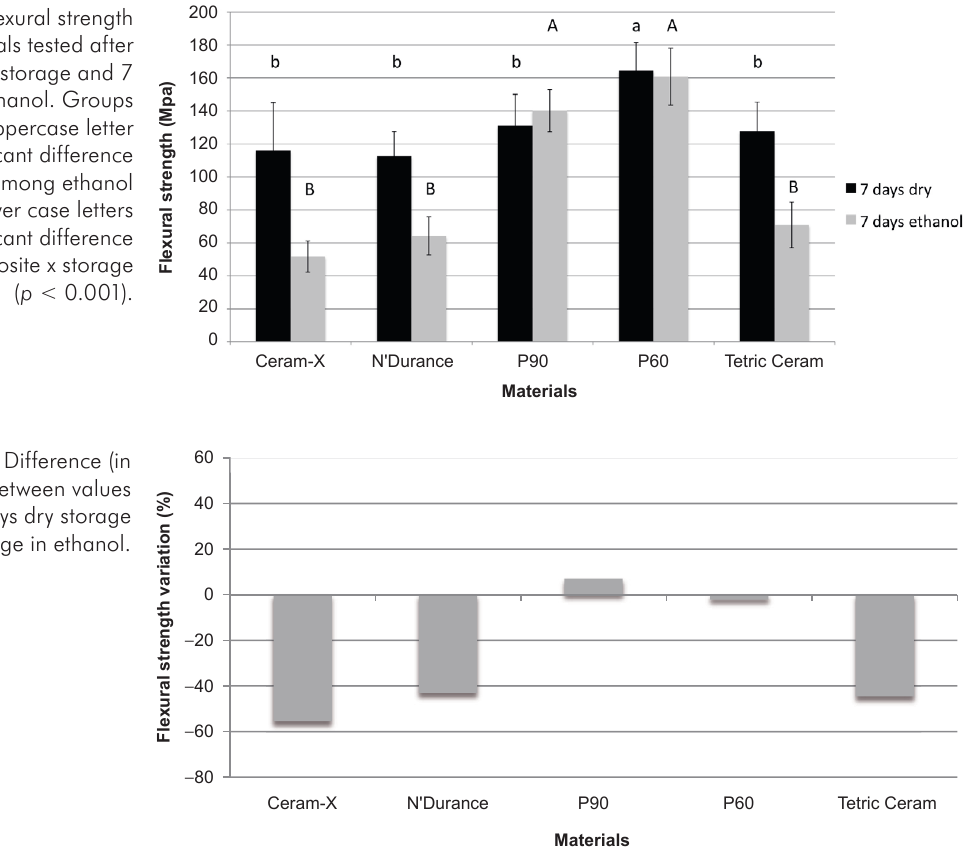
Figure 3 - Flexural strength values for materials tested after 7 days in dry storage and 7 days storage in ethanol. Groups